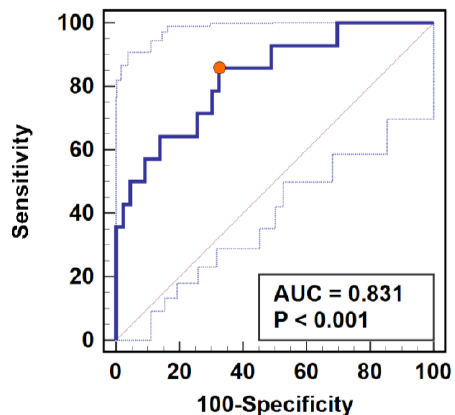
Figure 4. Predictive power of combined assessment of cortisol and C-reactive protein (CRP) as surgical site infection (SSI) marker. Determination of cortisol change at 24 h post-incision adjusted to baseline concentration (Δ24/0) was combined with CRP quantification at 72 h post-incision. Data presented as receiver operating characteristics (ROC) curve. AUC, area under ROC curve representative of marker accuracy with 95% confidence interval. Closed orange circle indicates an optimal cut-off corresponding with the highest combined sensitivity and specificity.